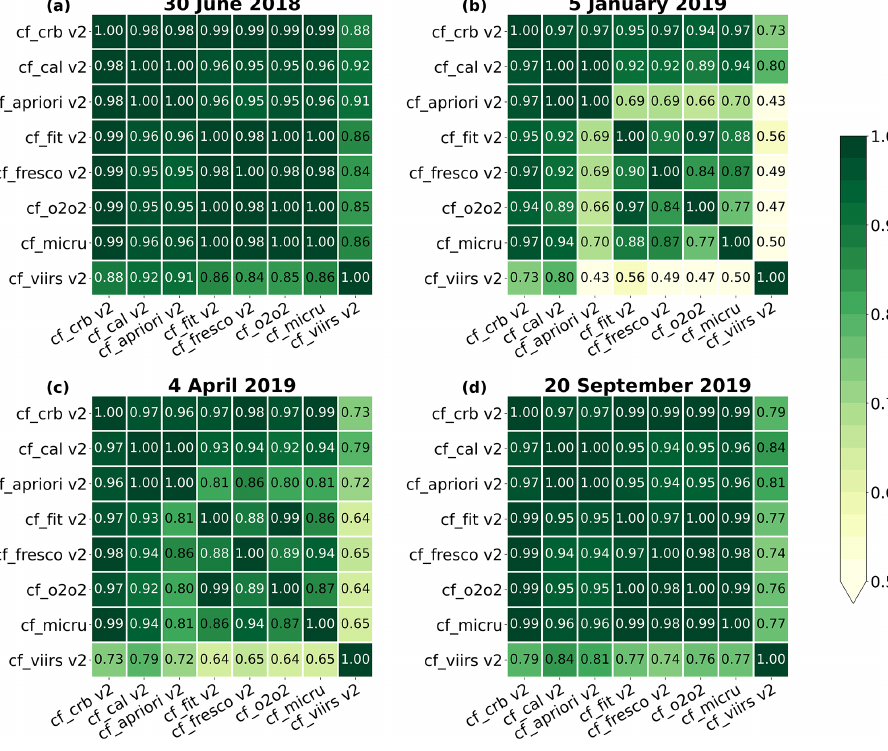
Figure 5. Tabular intercomparison of the correlations between the version 2 cloud fractions from ROCINN CRB, ROCINN CAL, OCRA a priori, the NO 2 fitting window (cf_fit), FRESCO, O 2 –O 2 , MICRU, and VIIRS for Europe and (a) the summer day, (b) the winter day, (c) the spring day, and (d) the autumn